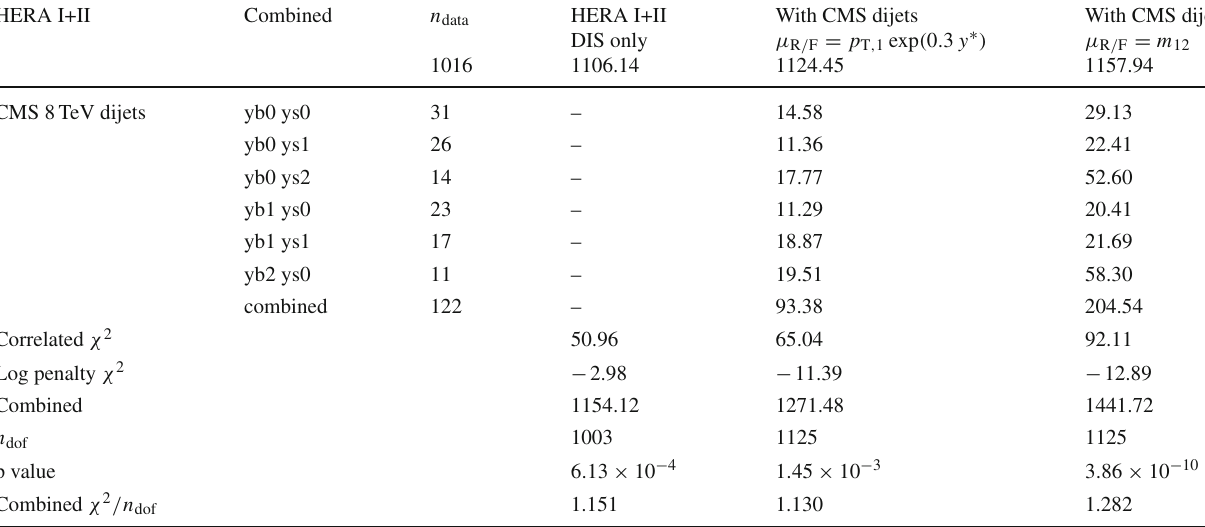
Table 4 Partial χ 2 values for the NLO fits of Sect. 4.2